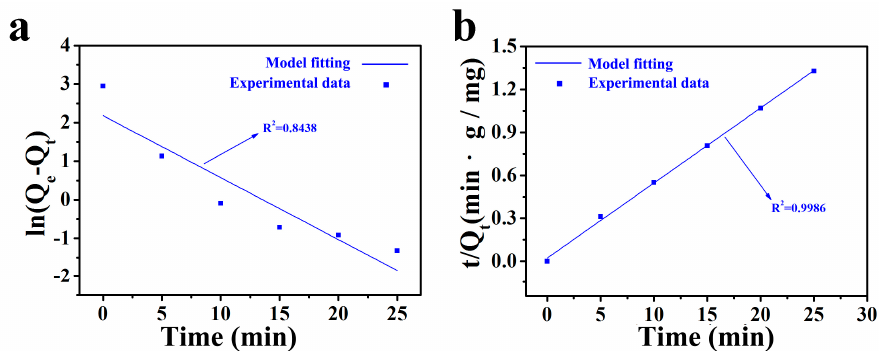
Figure 9. Pseudo-first order adsorption kinetics ( a ) and pseudo-second order kinetics ( b ) for the MB adsorption by CCT-BFO. The pH values of the MB aqueous solutions are 7.